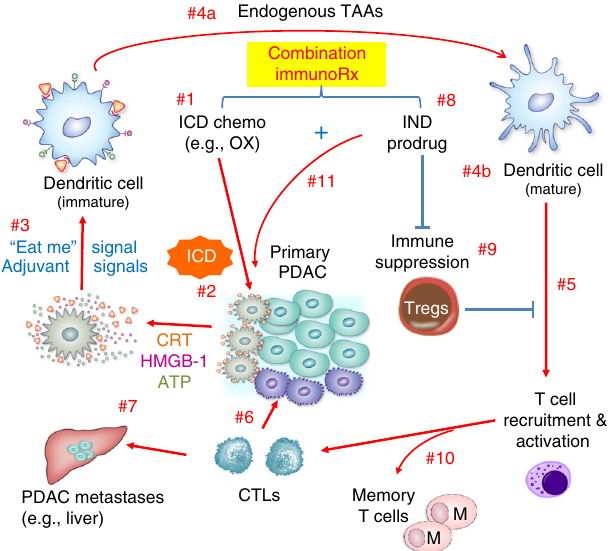
Fig. 1 Schematic to illustrate how dual delivery of OX and IND may impact the anti-PDAC immune response. We hypothesized that nano-enabled co- delivery of a chemotherapeutic agent, which provides an ICD stimulus, and IND, which interferes in the IDO pathway, may combine to trigger a robust PDAC immune response. OX (#1) induces an ICD response (#2) in which CRT expression on the dying tumor cell surfaces provides an “ eat-me ” signal for DC uptake, as well as the release of HMGB-1 and ATP that deliver adjuvant stimuli to DC (#3). Following uptake of the dying tumor cells by DC, their maturation and cross-presentation of endogenous tumor- associated antigens (TAAs) (#4), the recruitment and activation of CD8 + T cells (#5) will lead to granulysin and perforin mediated killing of primary (#6) and metastatic cancer cells (#7). The concomitant delivery of IND-PL (#8) interferes in the IDO metabolic pathway, which can lead to